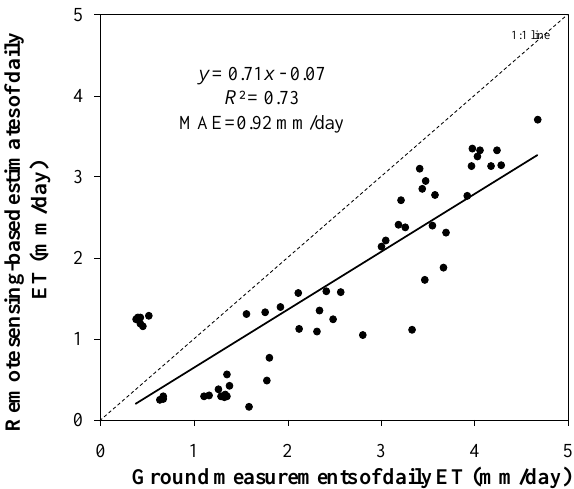
Fig. 5. Comparison of satellite-based daily actual ET estimates and Fig. 5 . Comparison of satellite-based daily actual ET estimates and eddy covariance Fig. 6 eddy covariance measurements of daily actual ET at the SD-Dem measurements of daily actual ET at the SD-Dem site. site.